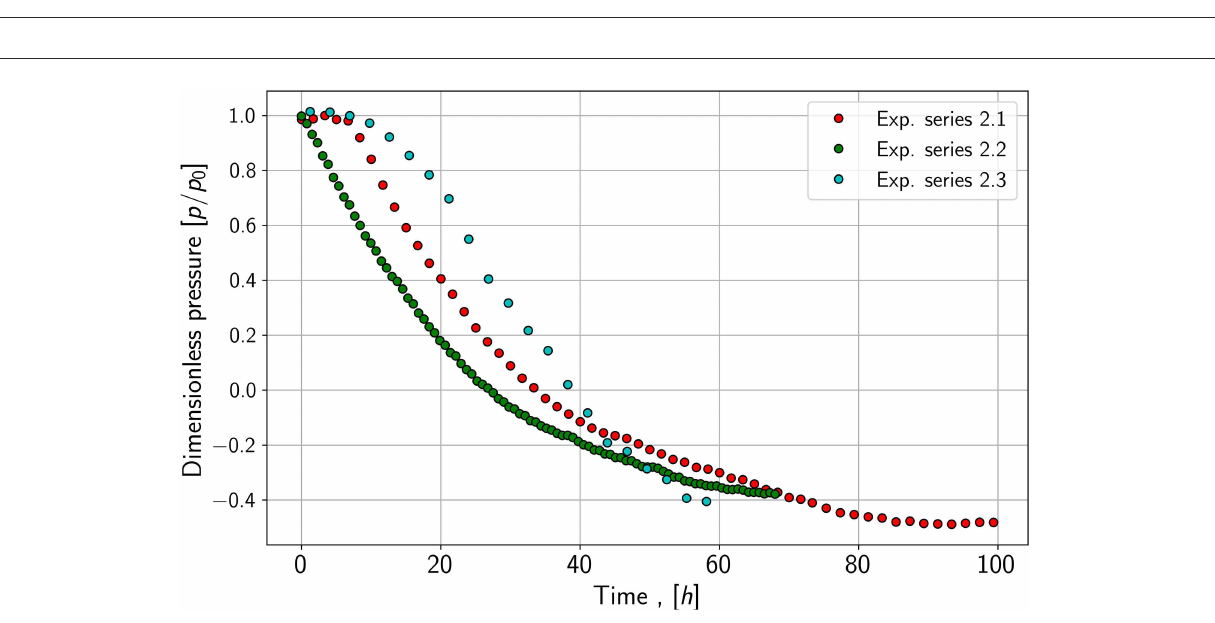
FIGURE3 Pressure drop in the gas phase of the reactor for species